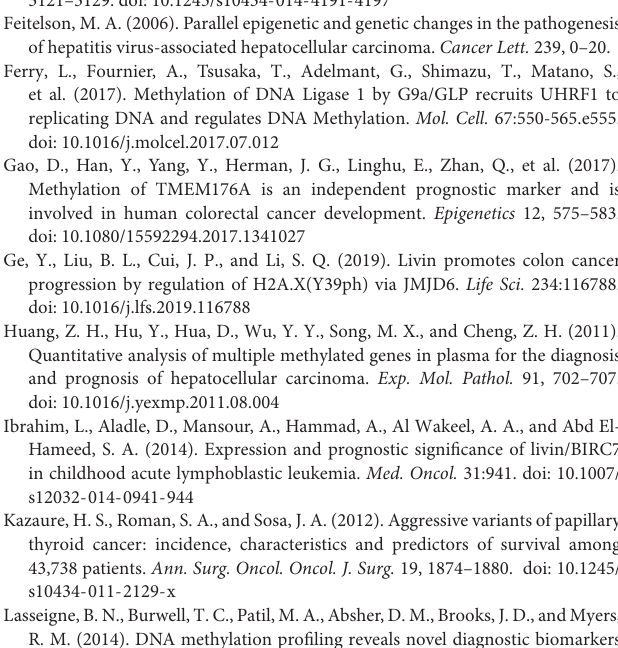
TABLE S1 | The results of univariate Cox analysis. HR, hazard ratio. TABLE S2 | The clinical information of the validated thyroid cancer